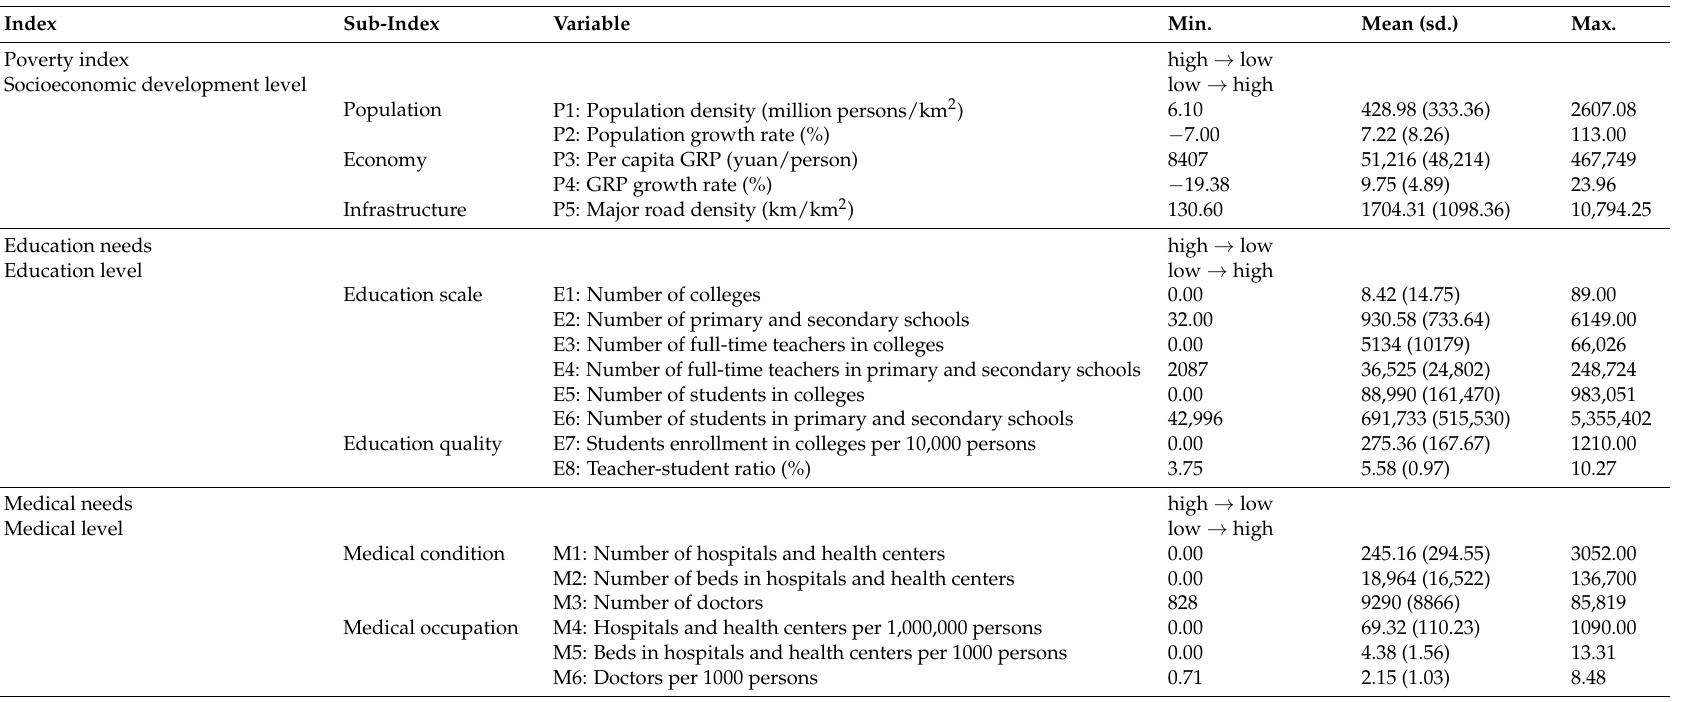
Table 1. Variables and indexes for describing local population